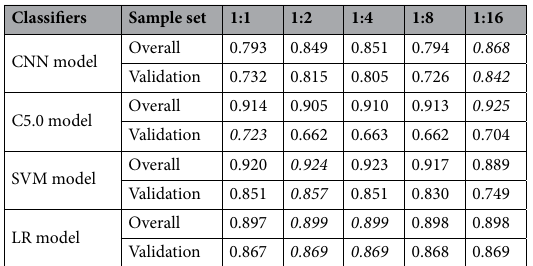
C5.0 model obtains 0.845, the SVM model obtains 0.857, and the LR model obtains 0.857. In terms of the chang- ing trend of the recall rate, the calculation results of the four types of models gradually decrease. Only the C5.0